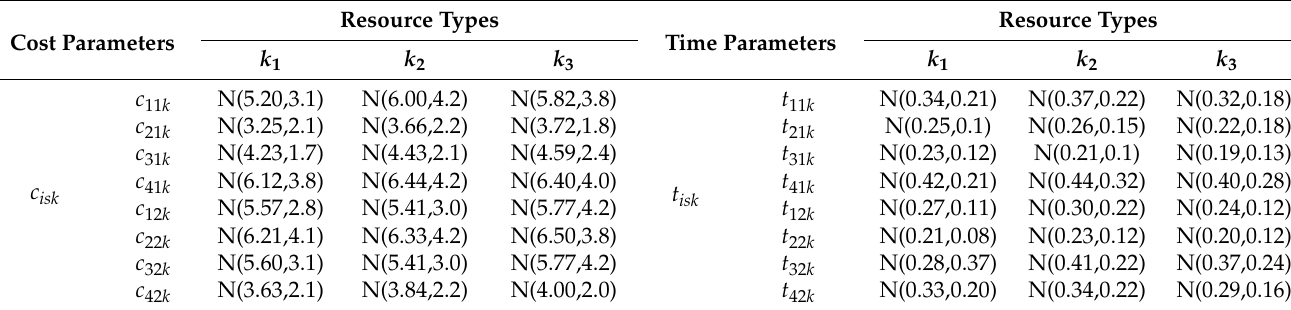
Table 5. Unit transportation cost and time of resources.